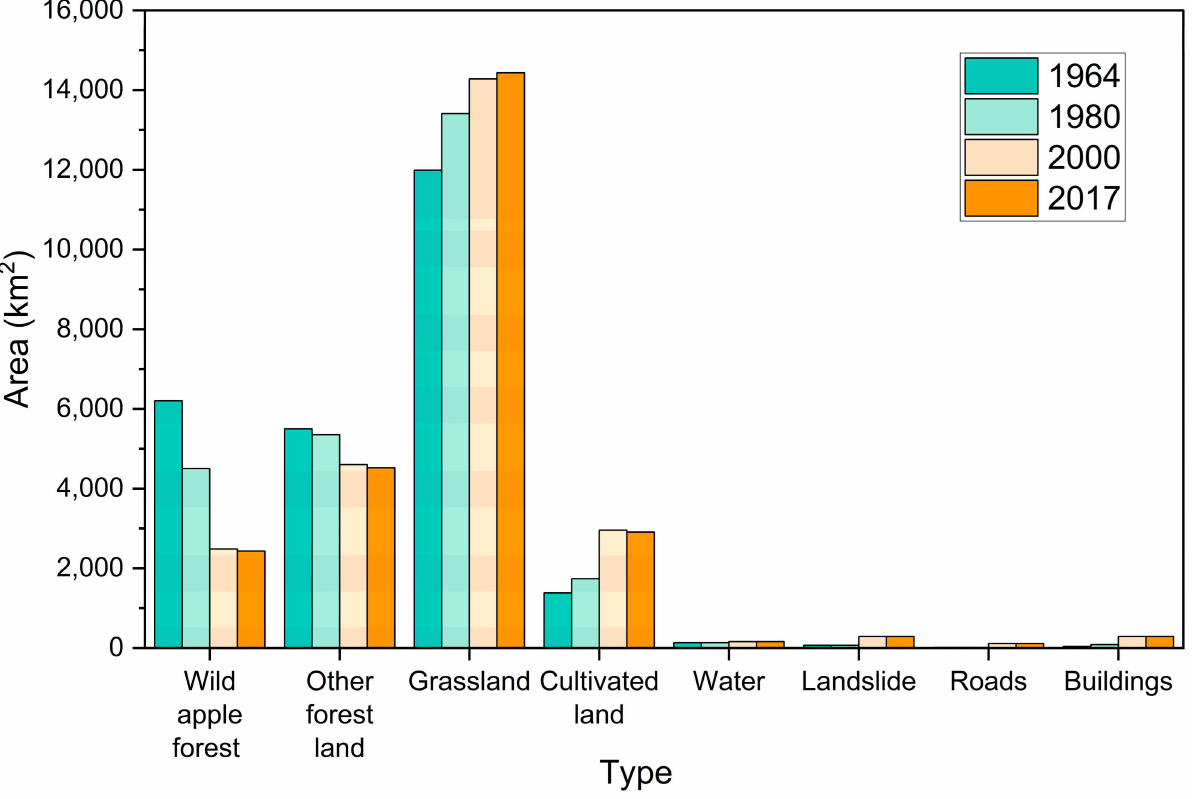
Figure 2. Changes in landscape pattern areas from 1964 to